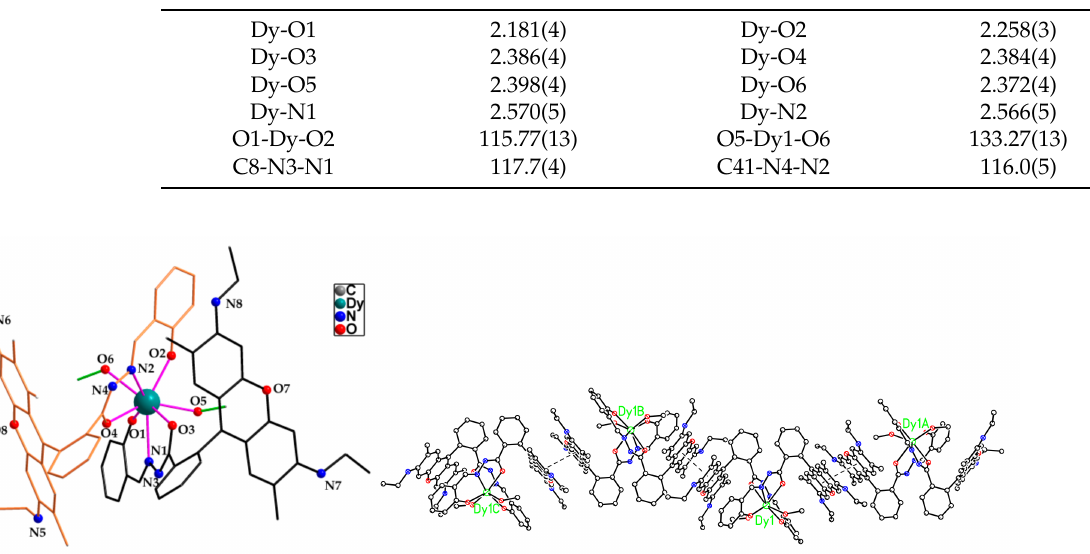
Figure 1. Crystal structure of the [Dy(HL-o) 2 (MeOH) 2 ] 3+ cation of 1 ( left ). Hydrogen atoms, anion, and crystallization solvents are omitted for clarify. 1D supromolecular chain showing the intermolecular π − π stacking ( right